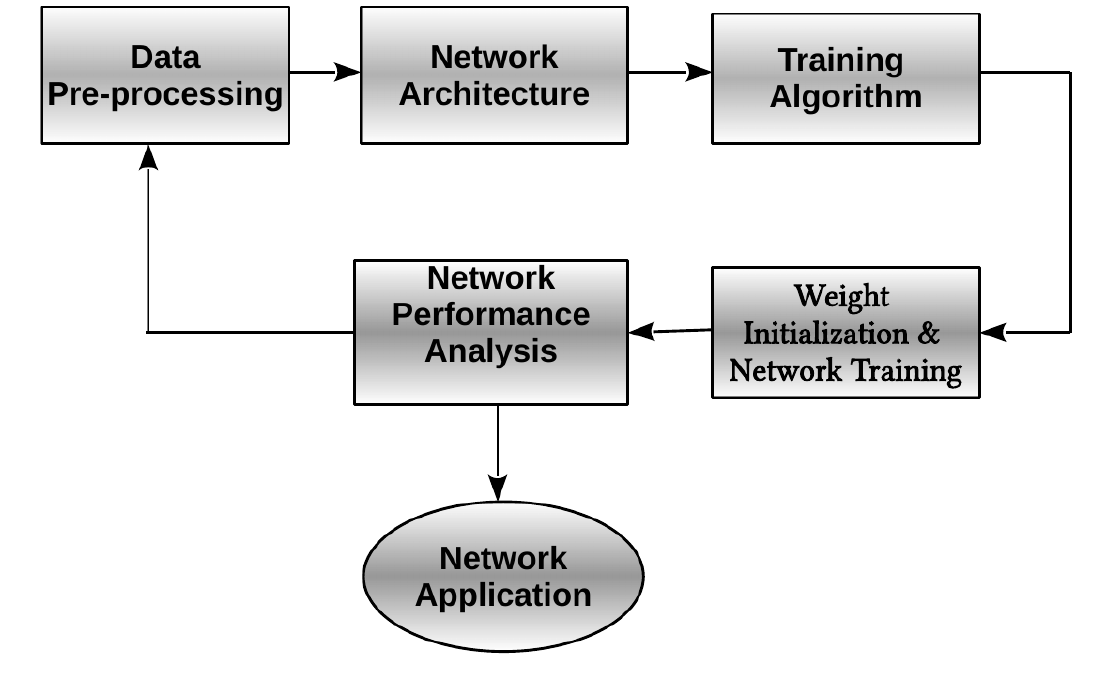
Figure 9. Flowchart of neural network training, analysis and application